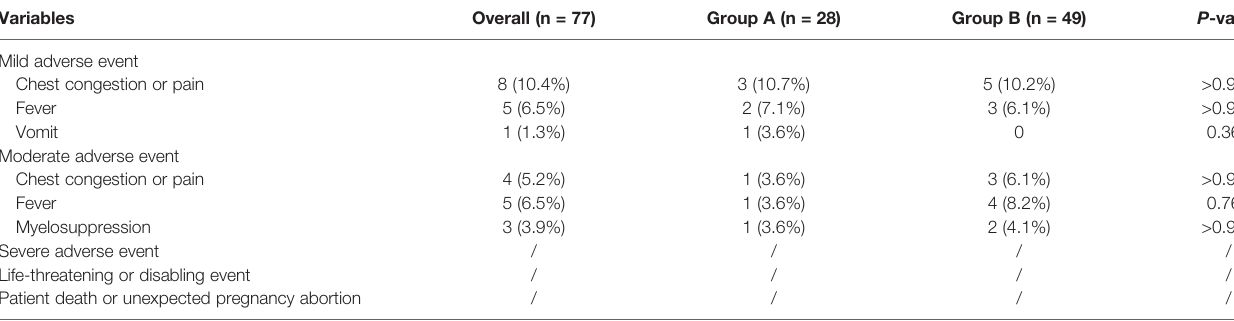
TABLE 3 | Details of DEB-BACE-related complications between ASTRI-NSCLC patients in groups A and B. Variables